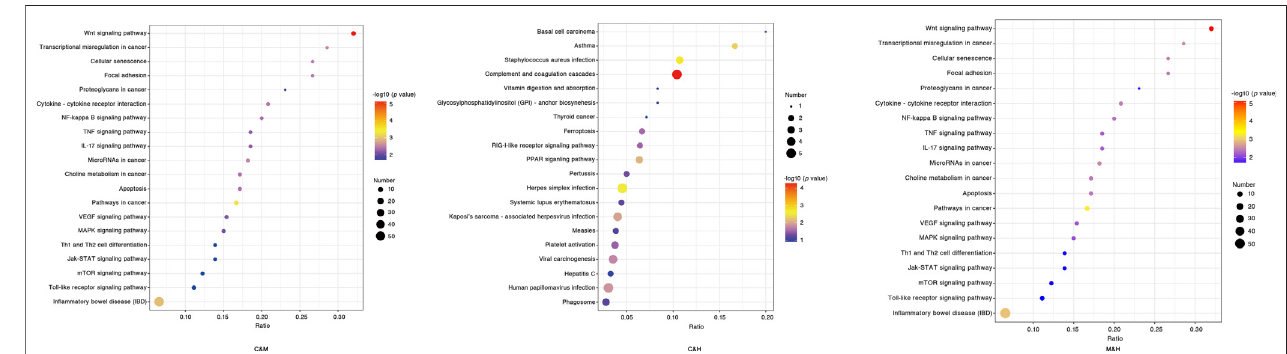
FIGURE8| KEGGenrichmentbubblechart.Thehorizontalcoordinateistheratioofthenumberofdifferentialproteinsinthecorrespondingpathwaytothenumber of total proteins identi fi ed in the pathway, with larger values indicating higher levels of differential protein enrichment in the pathway. The color of the points in the graph represents the p value of the hypergeometric test, and the color ranges from blue to red; the redder color means the smaller value, indicating the greater reliability of the testandthemorestatisticallysigni fi cant.Thesizeofthedotsrepresentsthenumberofdifferentialproteinsinthecorrespondingpathway,withlargerdotsindicating